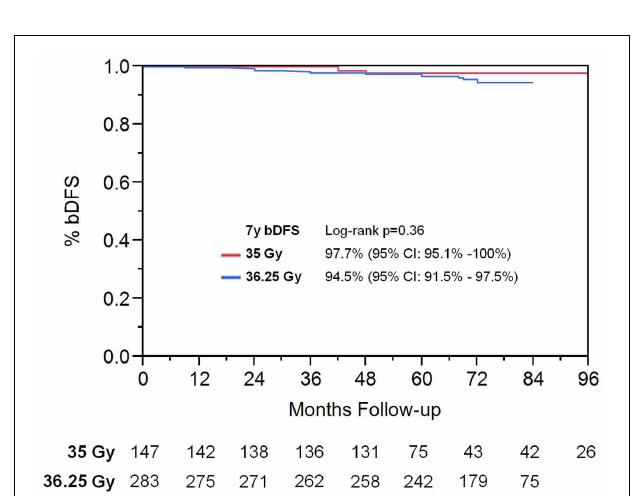
FIGURE 4 | Biochemical disease-free survival stratified byT-stage .